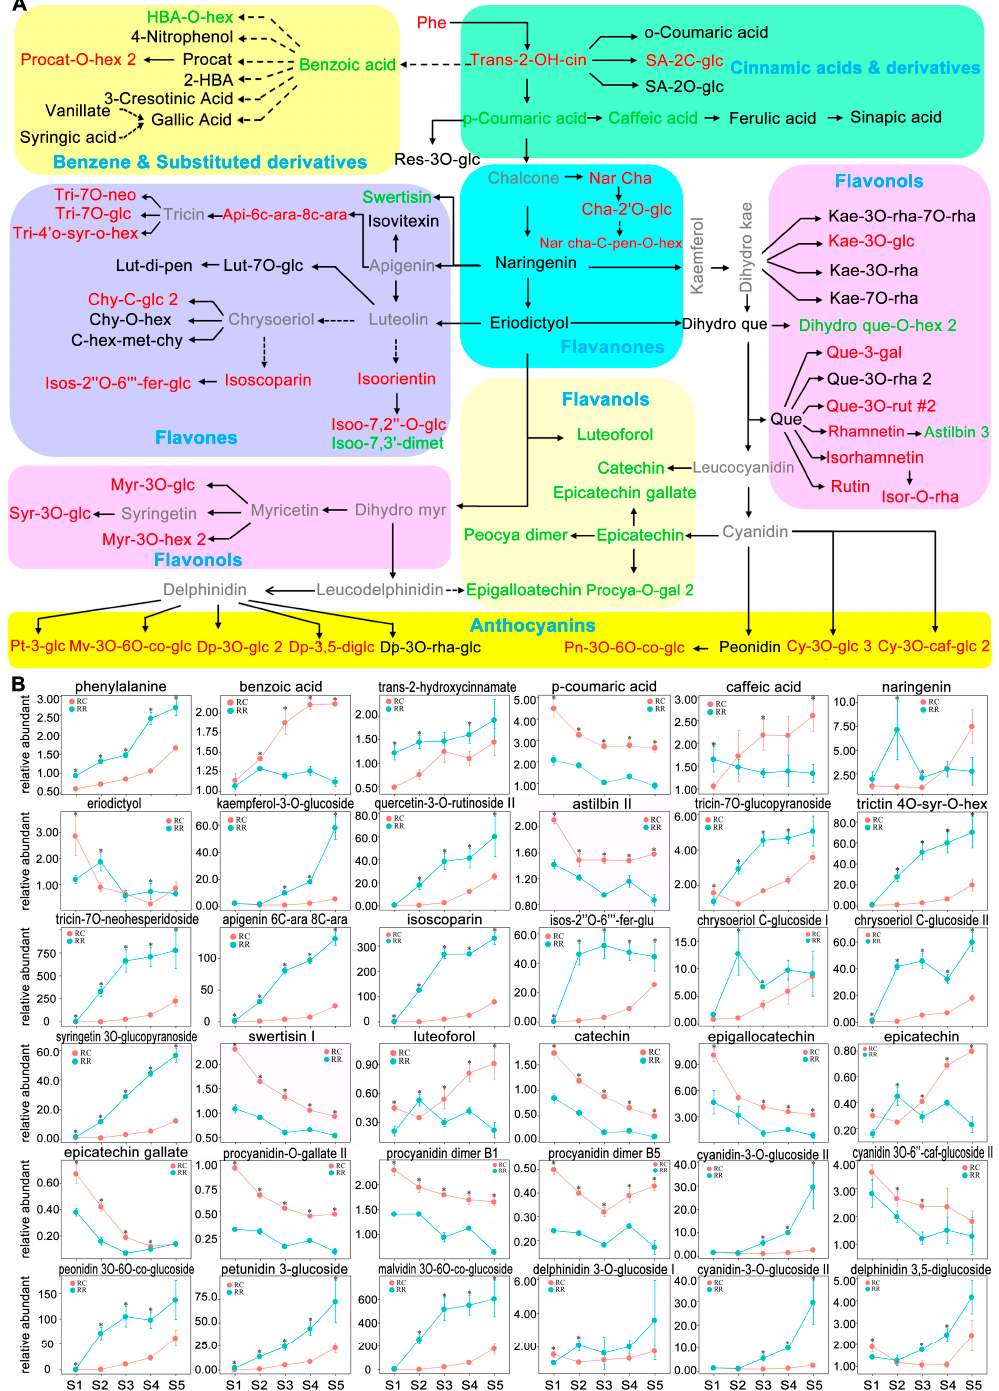
Figure 3. ( A ) Visualization of metabolic dynamics of secondary metabolism in skin tissues of developing grape berries. Representative metabolites with significantly statistical increases and declines more than three stages in RR are written in red and green letters, respectively. Metabolites with black letters indicate their dynamic changes were not significantly different between root restriction (RR) and traditional cultivation (RC). Metabolites with grey letters represent undetected metabolites. ( B ) Partial of representative metabolites are presented. The relative levels of metabolites were averaged with three biological replicates. Bars represent standard errors. Significant differences were signaled by an asterisk ( p < 0.05) using t -test. Each color of background represents one subclass of phenolic